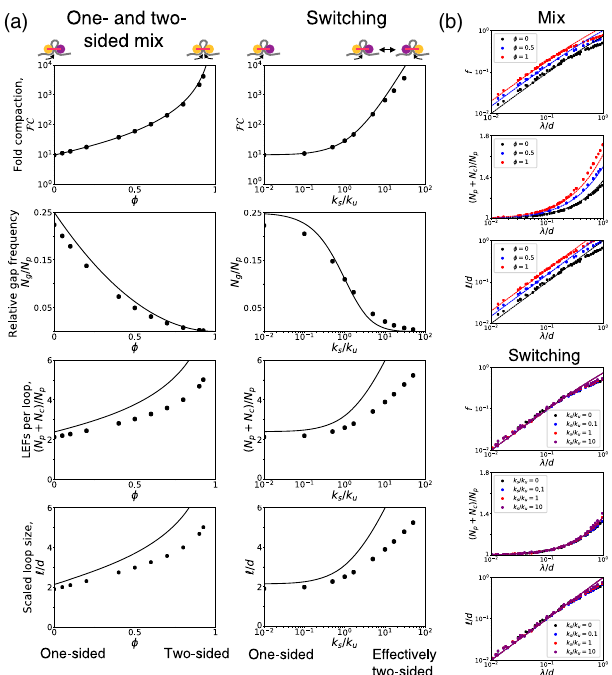
FIG. 3. (a) Simulation (points) and theory (lines) in the dense λ =d ≫ 1 regime for models with a mix of one- and two-sided LEFs (left) and switching (right). From top to bottom: FC , relative gap frequency ( N and scaled loop sizes ( l =d ). Note that ϕ ¼ 0 (or k pure one-sided extrusion, and ϕ ¼ 1 (or k tively) two-sided extrusion. (b) Fraction compacted ( f ), LEFs per loop, and scaled loop sizes in the sparse λ =d < 1